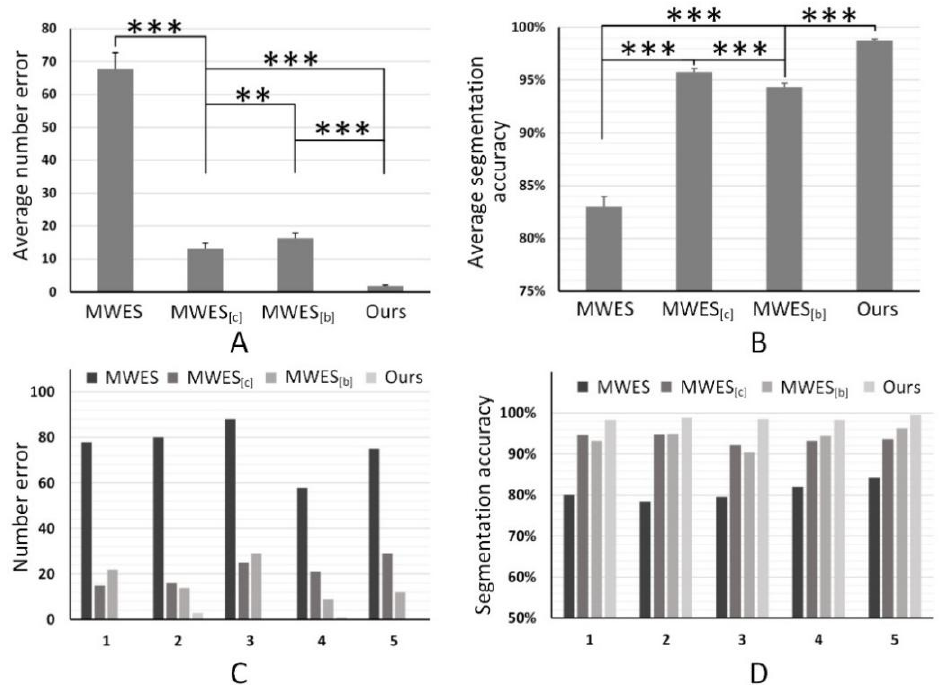
Figure 7. Statistical results of the number error and the segmentation accuracy. ( A ) represents the average number errors of 25 images in four methods. ( B ) represents the average segmentation accuracies of 25 images in four methods. ( C ) represents number errors of five different images in four methods. ( D ) represents segmentation accuracies of five different images in four methods. Error bars represent the standard error of mean (SEM) (*** p < 0.001; ** p < 0.01; T test with analysis of double-sample mean in pairs). Table 1. Time complexity